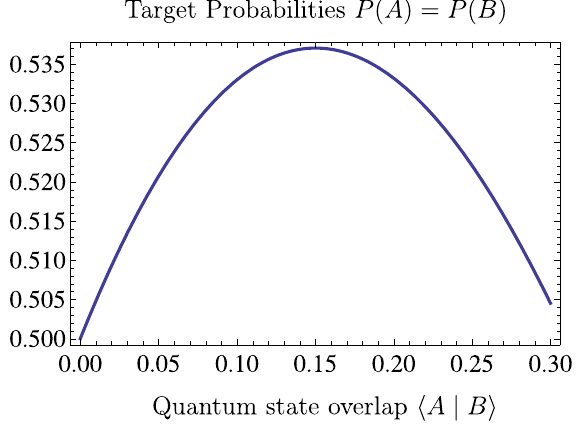
Figure 2. Dependence of the probabilities P ( A ) and P ( B ) to hit the respective targets on the quantum overlap � A | B � of the states associated with the targets. Quantum interference increases the target probabilities beyond 50%. However, the amount of increase is limited by the increasing losses caused by the destructive interference with | S � which represents the obstruction of line-of-sight paths. A maximum of P ( A ) = P ( B ) = 0.537 is reached at � A | B � = 0.150 , corresponding to a minimal fraction of 7.4% of photons hitting both targets even though the lines-of-sight are blocked at S